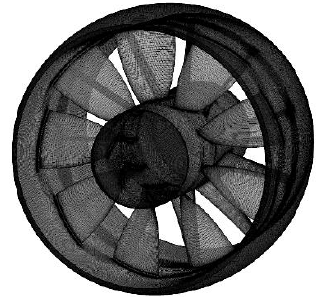
Table 3. The Y+ of rotor and stator part.